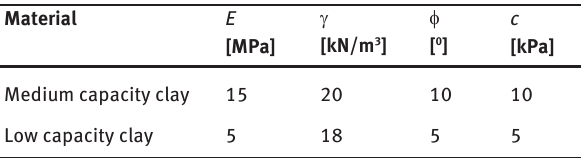
Table 1: Parameters of soil used in the bearing capacity